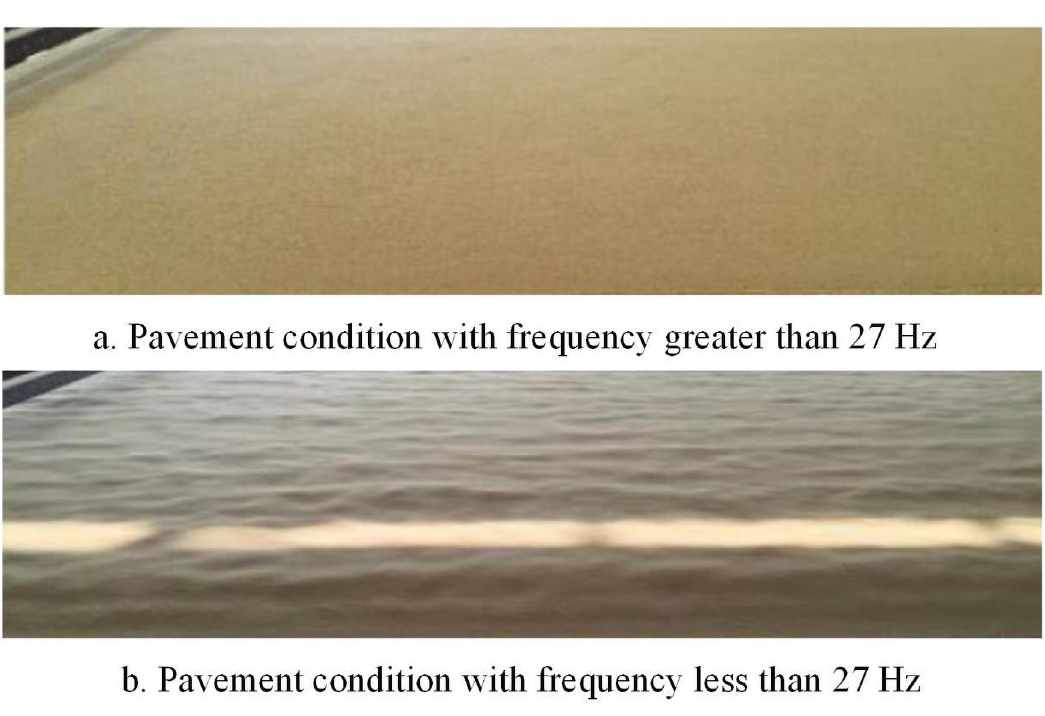
Fig 26. Pavement condition of different negative pressure fan frequencies.